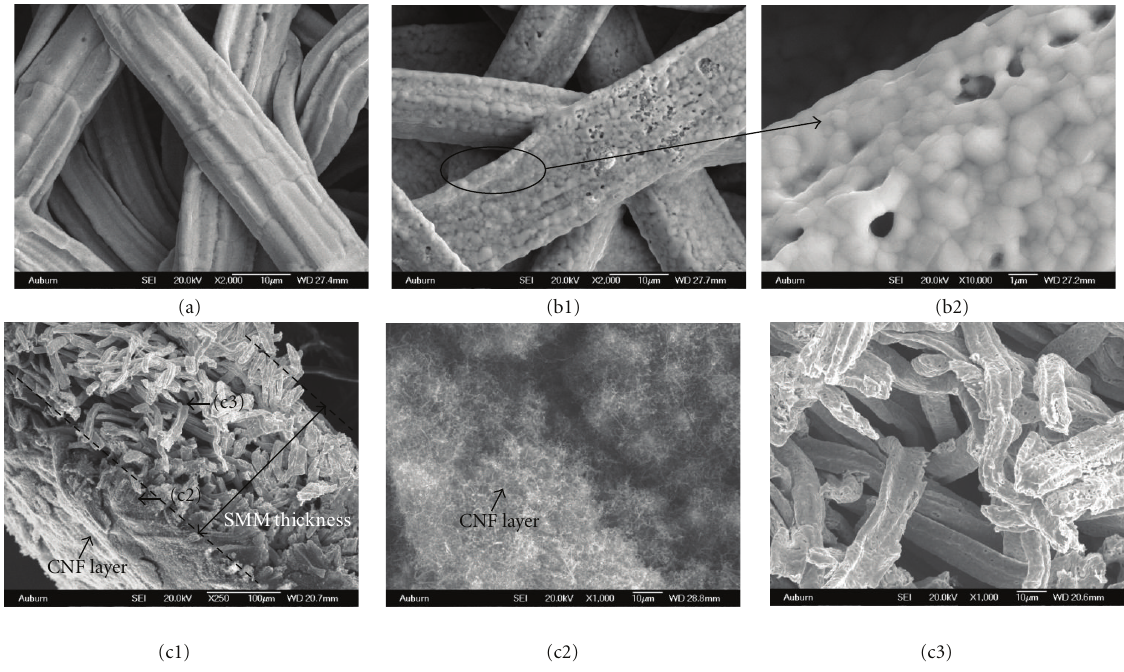
Figure 12: Surface deposition of CNF on 8 µ m SMM matrix: (a) SMM matrix, (b1) faceted SMM matrix, (b2) high magnification (10000x) of faceted SMM matrix, (c1) cross-sectional view after 11 min synthesis (250x), (c2) cross-sectional view at 1000x of the surface shown in c1, and (c3) cross-sectional view at 1000x of the matrix thickness centerline shown in c1.